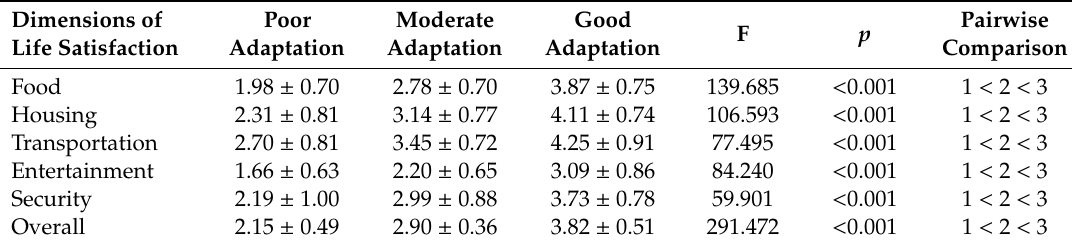
Table 2. Life satisfaction scores of the study population by cross-cultural adaptation (data presented as mean ± standard